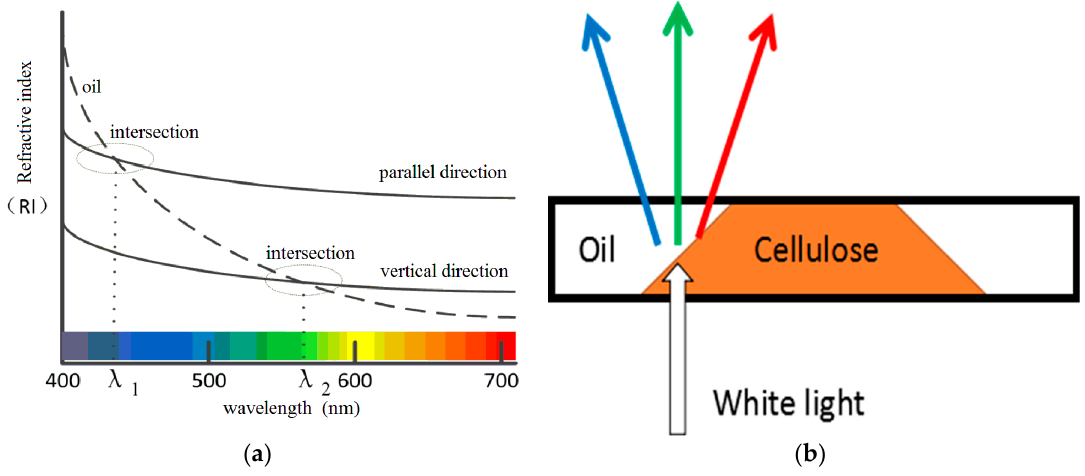
Figure 1. ( a ) Matching wavelength diagram; ( b ) dispersion of fiber.